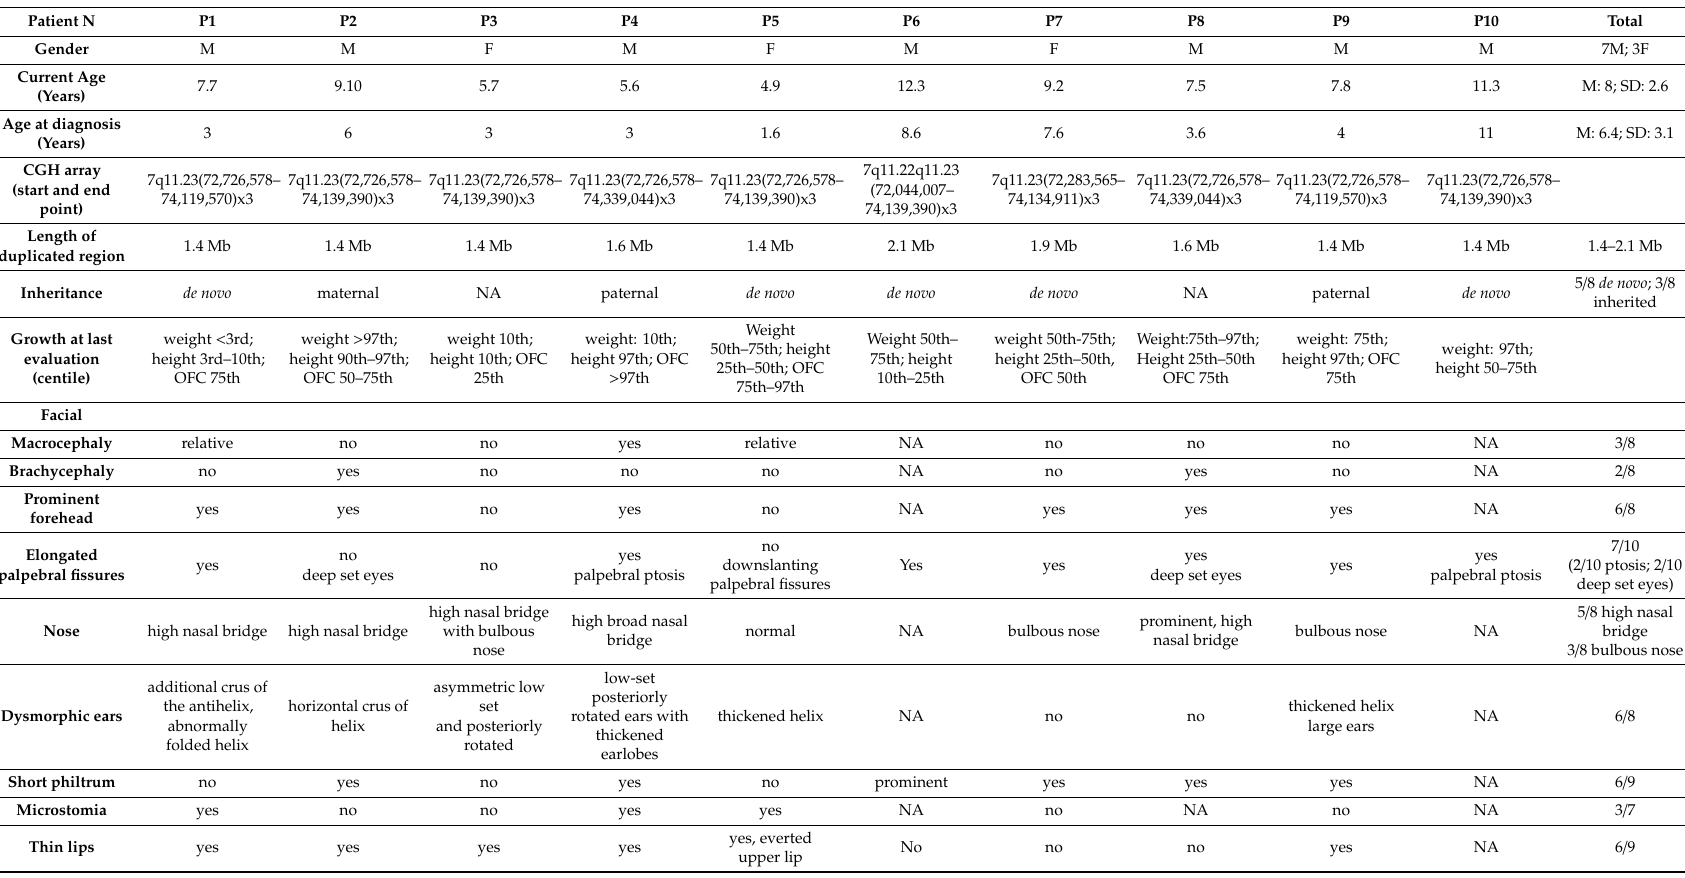
Table 1. Clinical features of our cohort of 10 patients a ff ected by 7q11.23 microduplication